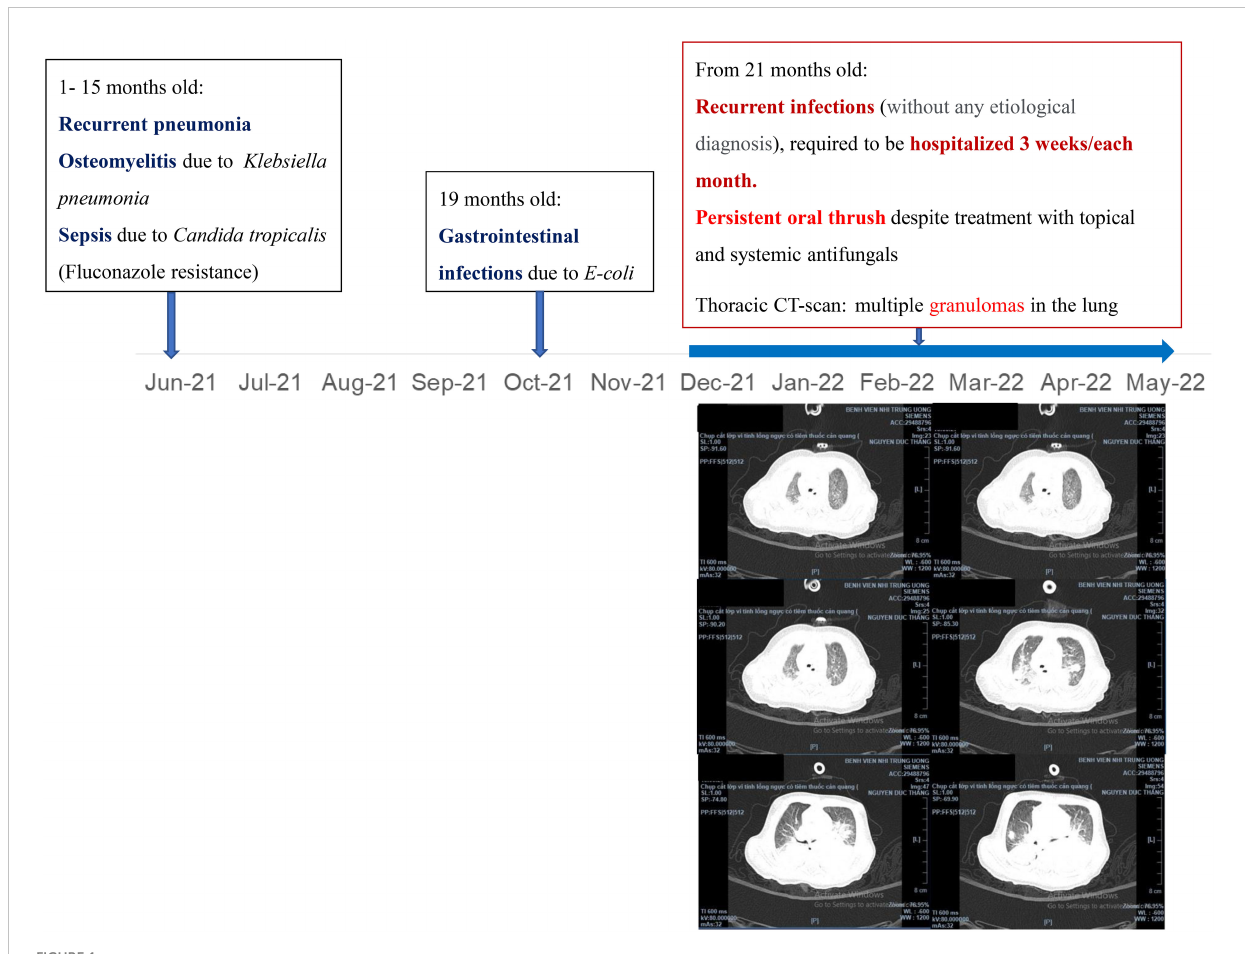
FIGURE 1 Medical history and thoracic CT-scan of the